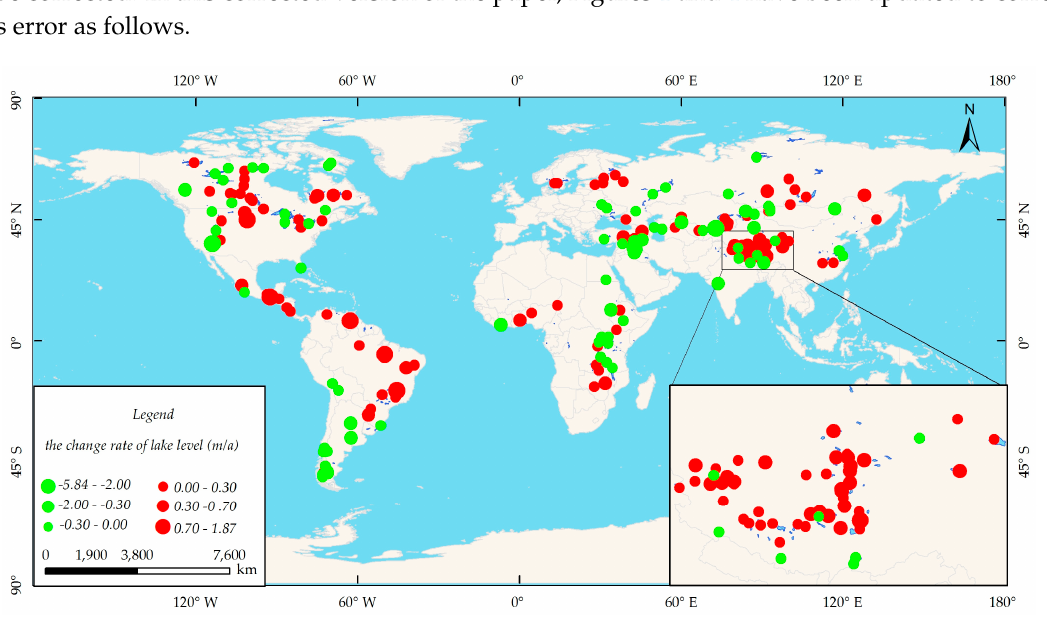
Figure 1. Classification of the change rates of lake levels.